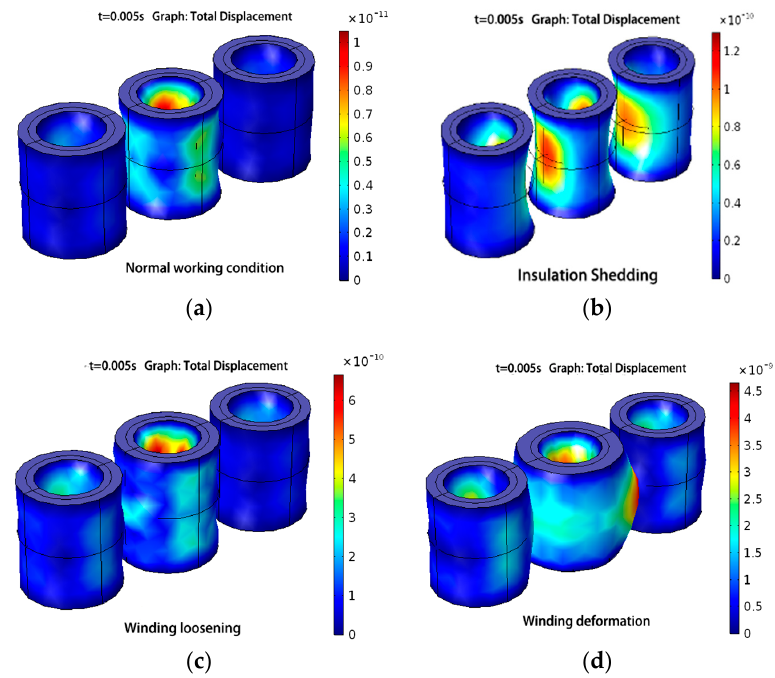
Figure 14. Axial diagram of the total displacement of windings under various working conditions. ( a ) Normai working; ( b ) Insulation Shedding; ( c ) Winding loosing and ( d ) Winding